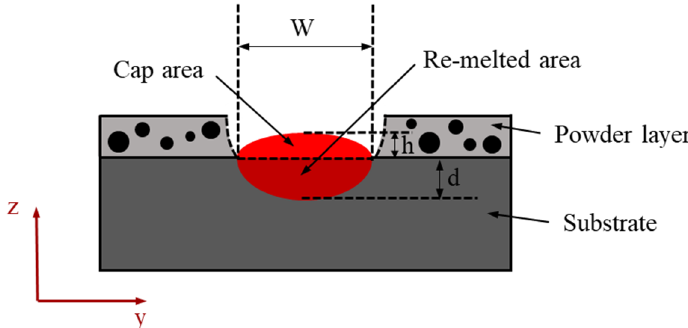
Figure 2. Assumption of the dual half-elliptical molten pool transverse cross section (the whole red portion in this figure). The top portion represents the cap area, while the bottom portion represents the re-melted area. h, d and W represent the cap height, re-melted depth and molten pool width, respectively. y and z represent the transverse direction and build direction,